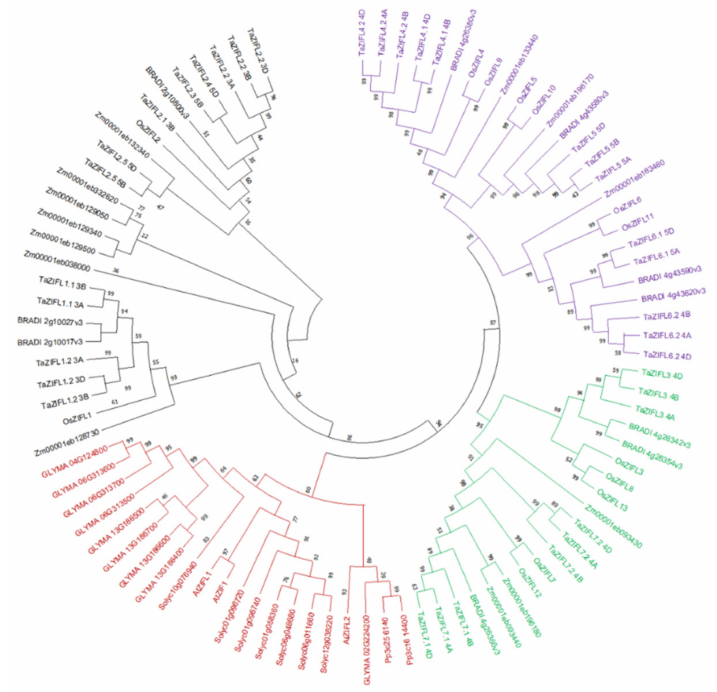
Figure 1. Phylogenetic analysis of ZIFL protein sequences. The putative ZIFL sequences for Zea mays (13 members), Brachypodium distachyon (10 members), Glycine max (9 members), Solanum lycopersicum (7 members) and Physcomitrella patens (2 members) Pfam ID PF07690 were used to extract MFS sequences from Ensembl, followed tree construction along with the rice (13 members), wheat (35 members) and Arabidopsis (3 members) ZIFL protein sequences.